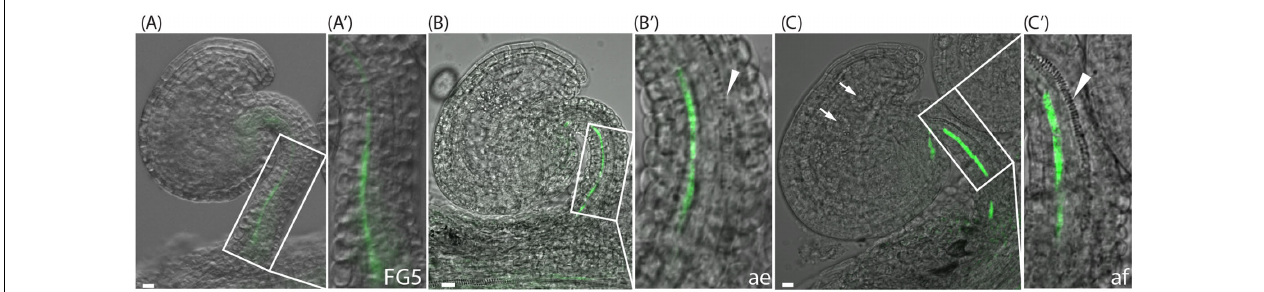
FIGURE 2 | SUC2pro:GFP expression and xylem differentiation in ovules at the pre-anthesis stage, after emasculation and post-fertilization. (A–C) Merged confocal and transmitted light images of SUC2pro:GFP ovules at pre-anthesis, stage FG5 (A,A (cid:48) ) , at stage FG7after emasculation (ae) (B,B (cid:48) ) , and at two-nucleate endosperm stage, shortly after fertilization (af) (C,C (cid:48) ) . (A (cid:48) –C (cid:48) ) show higher magnifications of the boxed areas in (A–C) . Green indicates SUC2 expression in the third cell file, arrowheads indicate differentiating xylem in the fifth cell file, arrows in (C) indicate endosperm nuclei. Bars = 10 µ m. All images are representatives of at least 10 independent